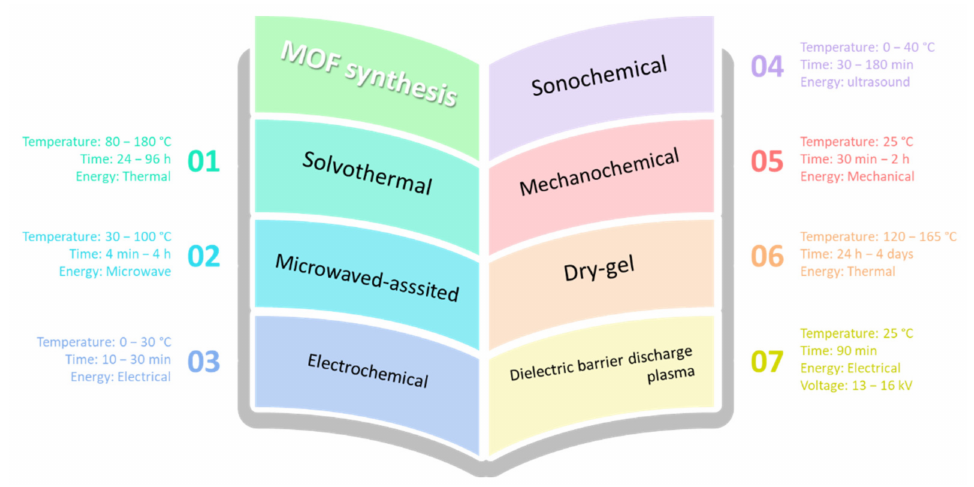
Figure 3. Most used synthesis methods to obtain Fe-MOFs